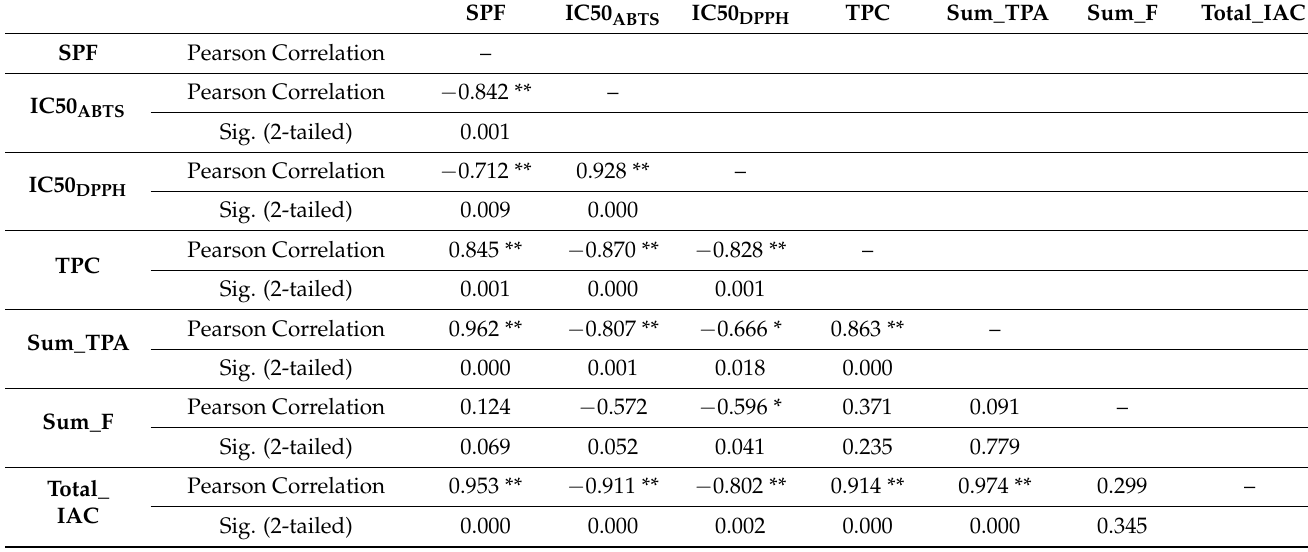
Table 3. Correlation table comparing SPF factor (SPF), antioxidant activity (IC50ABTS and